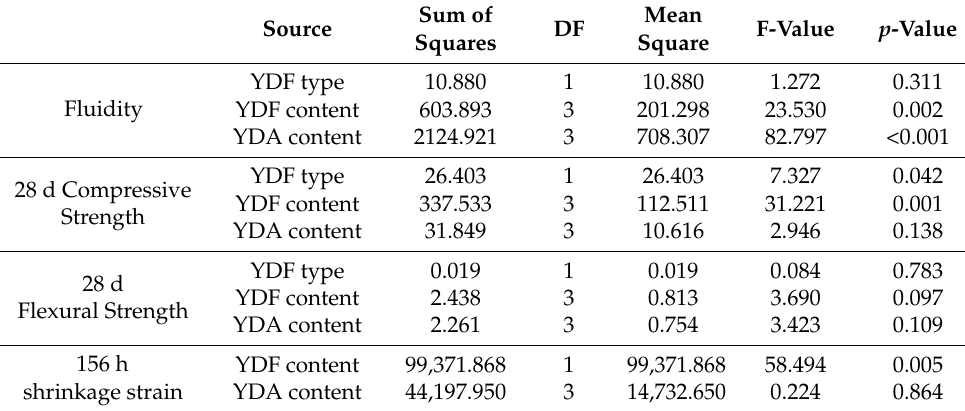
Table 5. Analysis of variance results for concrete